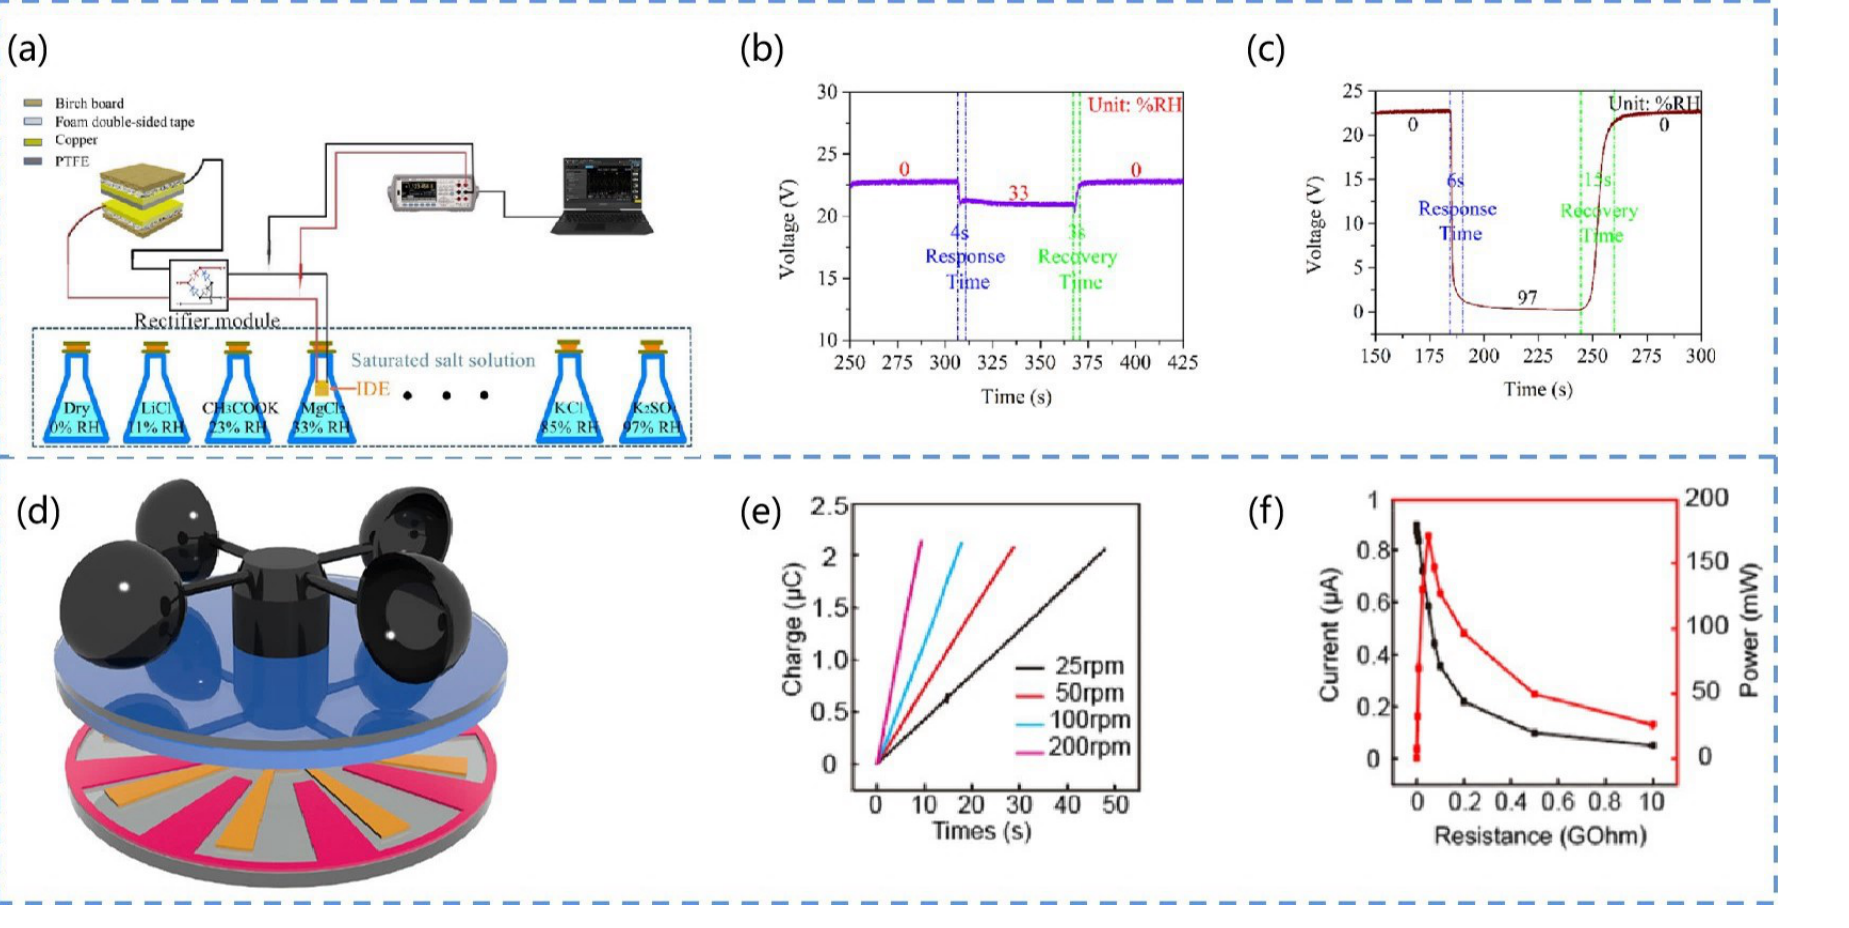
Figure 4. ( a ) Schematic diagram of the fabrication and operation of a TENG-based humidity sensing system. ( b ) Response of the device at 33% humidity conditions. ( c ) Response of the device at 97% humidity conditions. Reprinted from [46] with permission from Elsevier. ( d ) Schematic diagram of the structure of the coplanar electrode DC-TENG. ( e ) Output of the TENG for charging the capacitor at different rotational speeds. ( f ) Output of the TENG at 400 r/min rotation speed. Reprinted from [47] with permission from Wiley Online